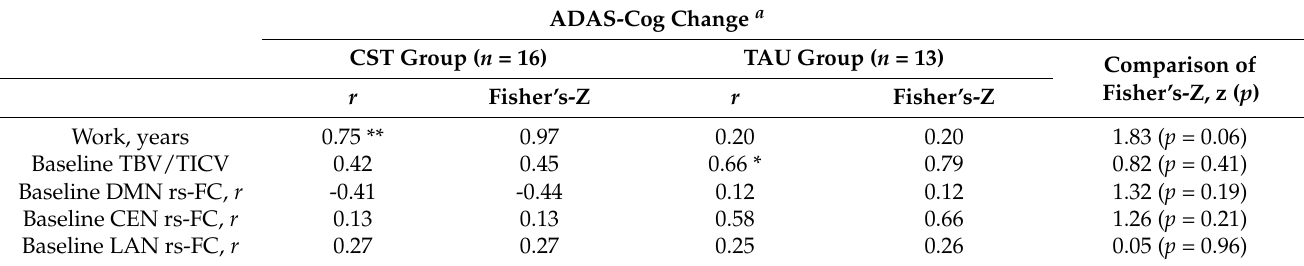
Table 3. Partial correlation between baseline network connectivity and cognitive changes controlling for age and gender, and Fisher’s Z transformation.